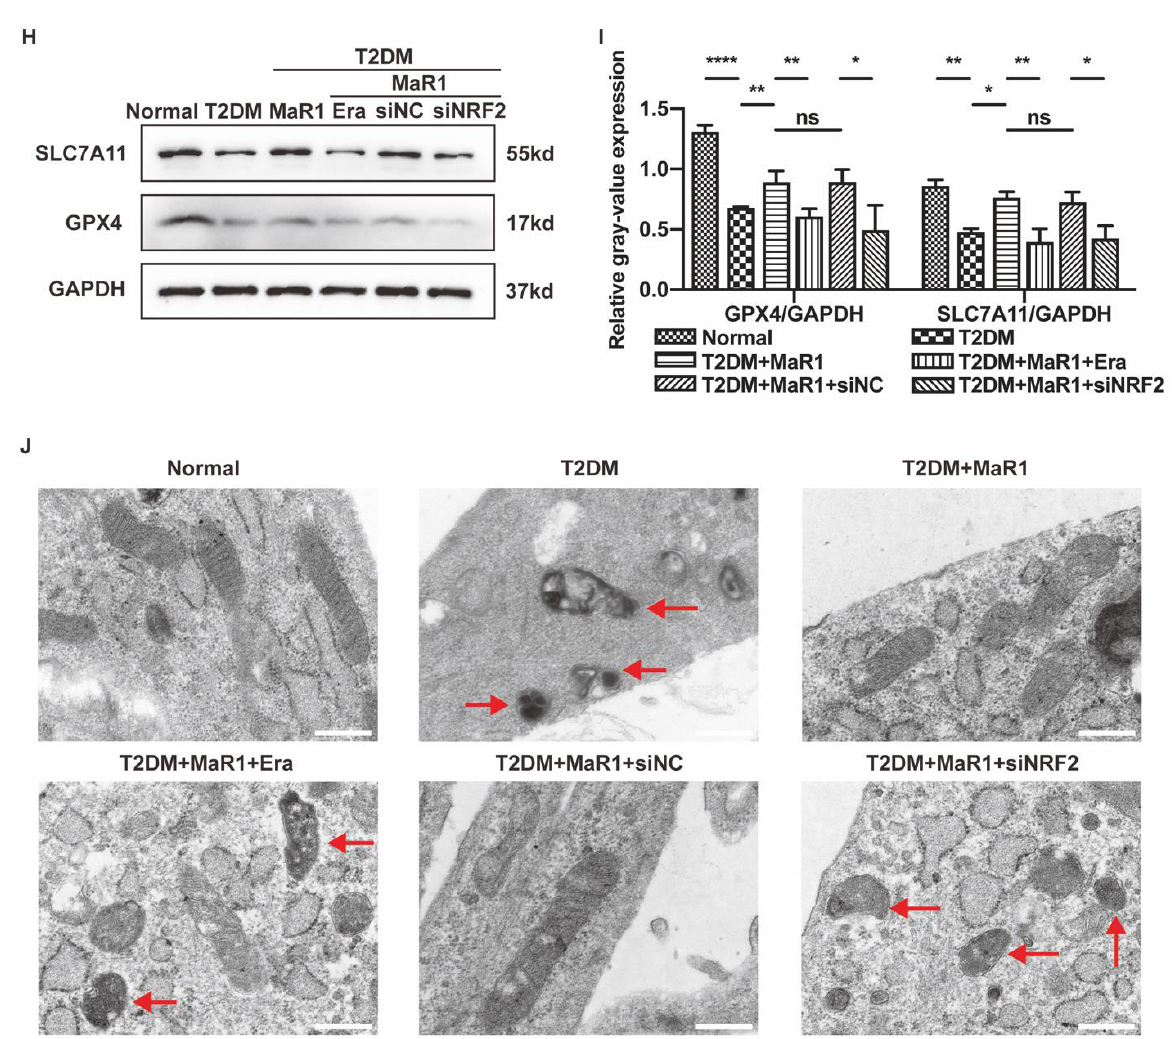
Figure 3. MaR1 ameliorated high-glucose-induced osteoblast ferroptosis via NRF2 activation. ( A ) The survival of the osteoblasts was examined using the Cell Counting Kit-8 assay. ( B ) Level of intracellular GSH. ( C ) Iron ion content. ( D ) The lipotropic dye, the Bodipy-C11 fluorescence probe, was used to identify lipid ROS. Green, oxidized lipids; red, normal lipids; blue, all nuclei. Scale bar = 50 µ m. ( E ) The quantitative analysis of mean Bodipy-C11 fluorescence intensity. ( F ) Flow cytometry was used to detect the levels of intracellular ROS. ( G ) A malondialdehyde assay was used to measure lipid peroxidation. ( H ) Western blot analysis was used to determine the protein levels of GPX4 and SLC7A11. ( I ) Protein level quantification and analysis. ( J ) Images of MC3T3-E1 cells after various treatments were taken using transmission electron microscopy. Altered mitochondria are indicated by arrows. Scale bars = 500 nm. Data are presented as means ± SDs from three independent experiments (n = 3). ns p > 0.05; * p < 0.05; ** p < 0.01; *** p < 0.001; **** p < 0.0001. SiNC: siRNA negative control; siNRF2: siRNA of NRF2.